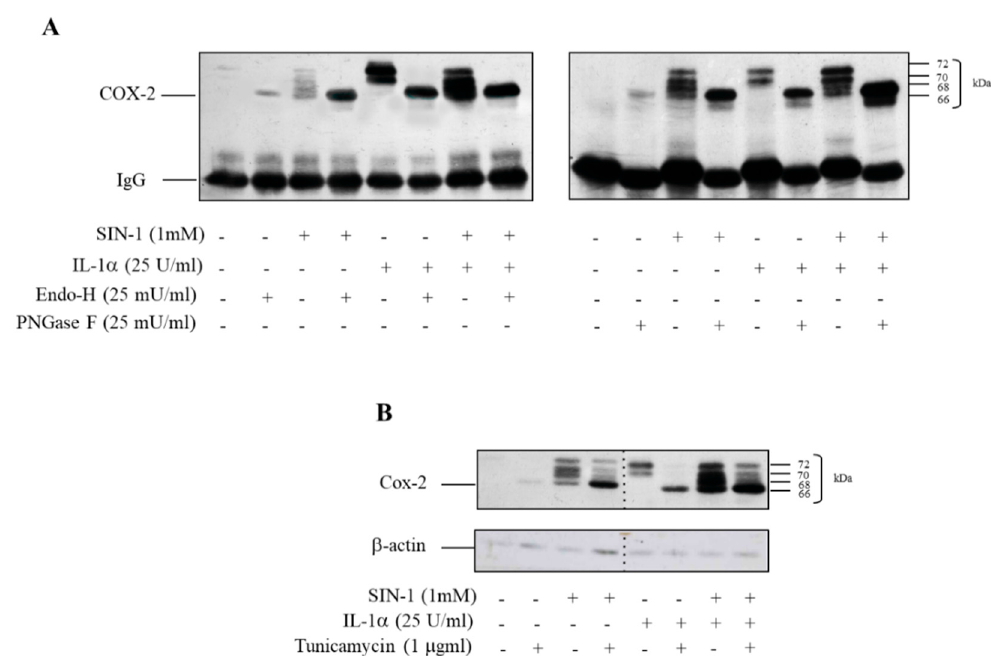
Figure 3. SIN-1 alters the glycosylation pattern of COX-2. HUVEC were incubated for 18 h with SIN-1 alone or in combination with IL-1 α . ( A ) After immunoprecipitation, endoglycosidase H, which cleaves high-mannose-type and hybrid oligosaccharide chains, or PNGase F, which cleaves N-linked tri- and tetraantennary complex-type chains, were added. ( B ) Incubation of cells is performed in the presence of tunicamycin. COX-2 expression was evaluated by Western blot analysis. β -actin was used as a control of protein loading. The lanes were run on the same gels but were non-contiguous. Results are representative of 3 independent experiments.